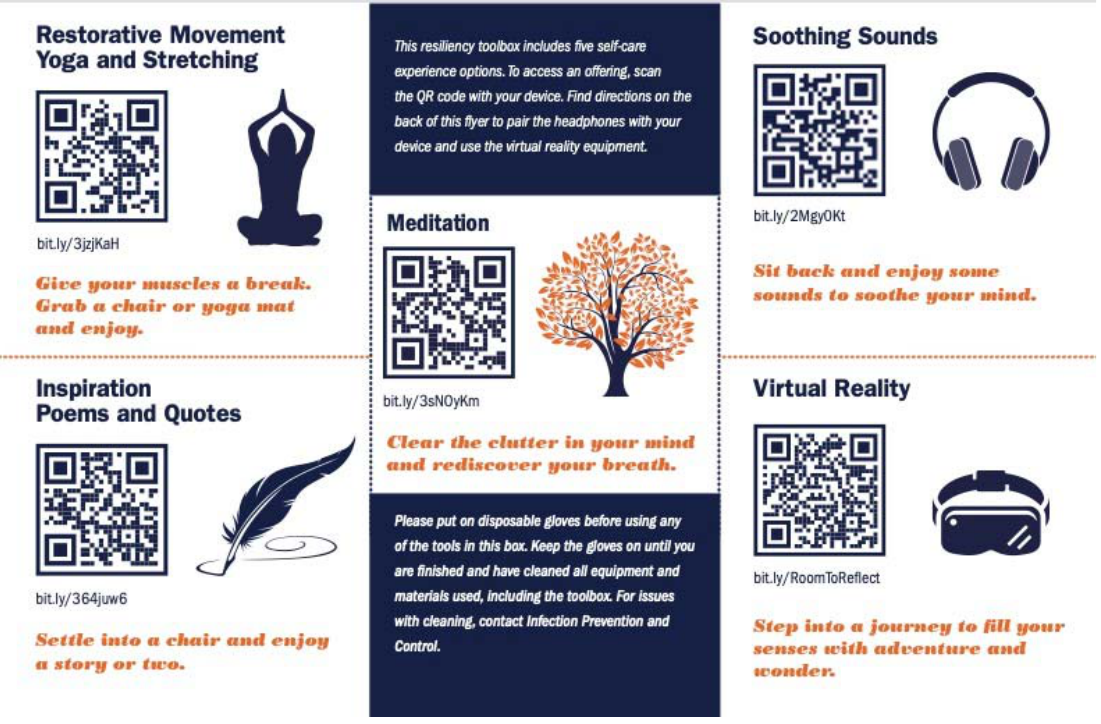
Figure 3. Poster Offerings with Quick Response